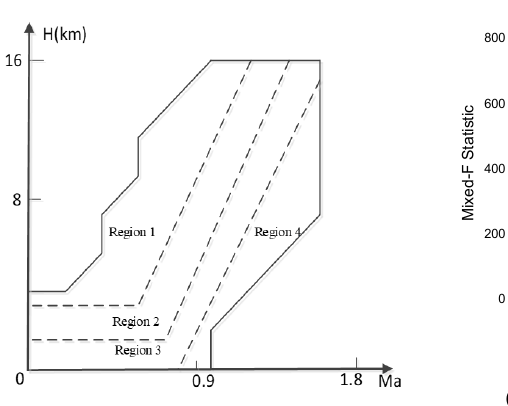
Figure 4. Sub-regions in the flight envelope and the mixed-F statistics in the sub-regions.